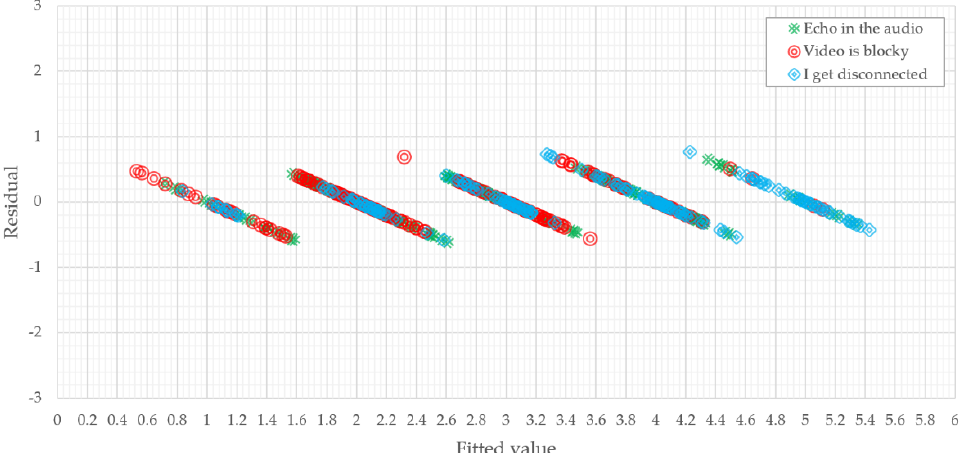
Figure 7. Updated residual plots for the three quality degradation types.